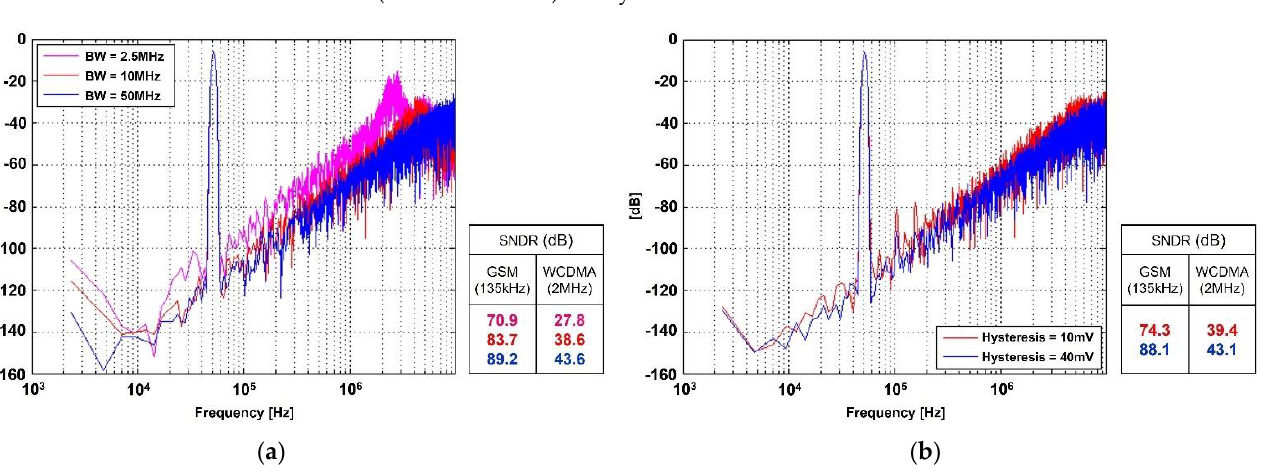
Figure 10. Modulator output spectrum with comparator non-ideality. ( a ) Pre-amp bandwidth and ( b ) Hysteresis.